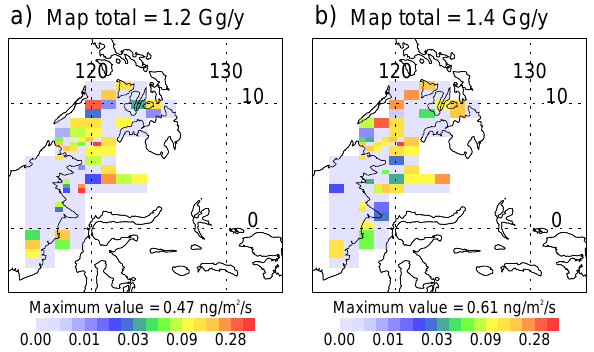
Fig. 7. For experiment A, considering only the ‘fine’ grid cells: a) shows the individual inversion solution (one of 25) with the lowest estimated CHBr 3 emission, and b) shows the individual solution with the highest estimated CHBr 3 emission. As in Fig. 6, the total emission from the ‘fine’ solution grid cells is noted above the plot (units are Gg CHBr 3 yr − 1 ).